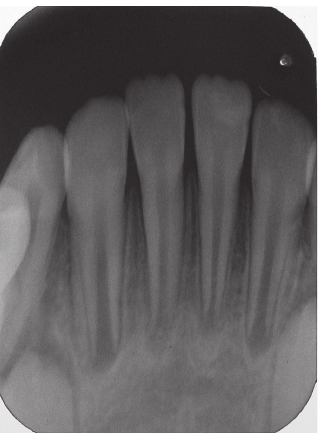
Figure 6: Six-month radiographic follow-up. Closure process of the apexes of the traumatized teeth continued